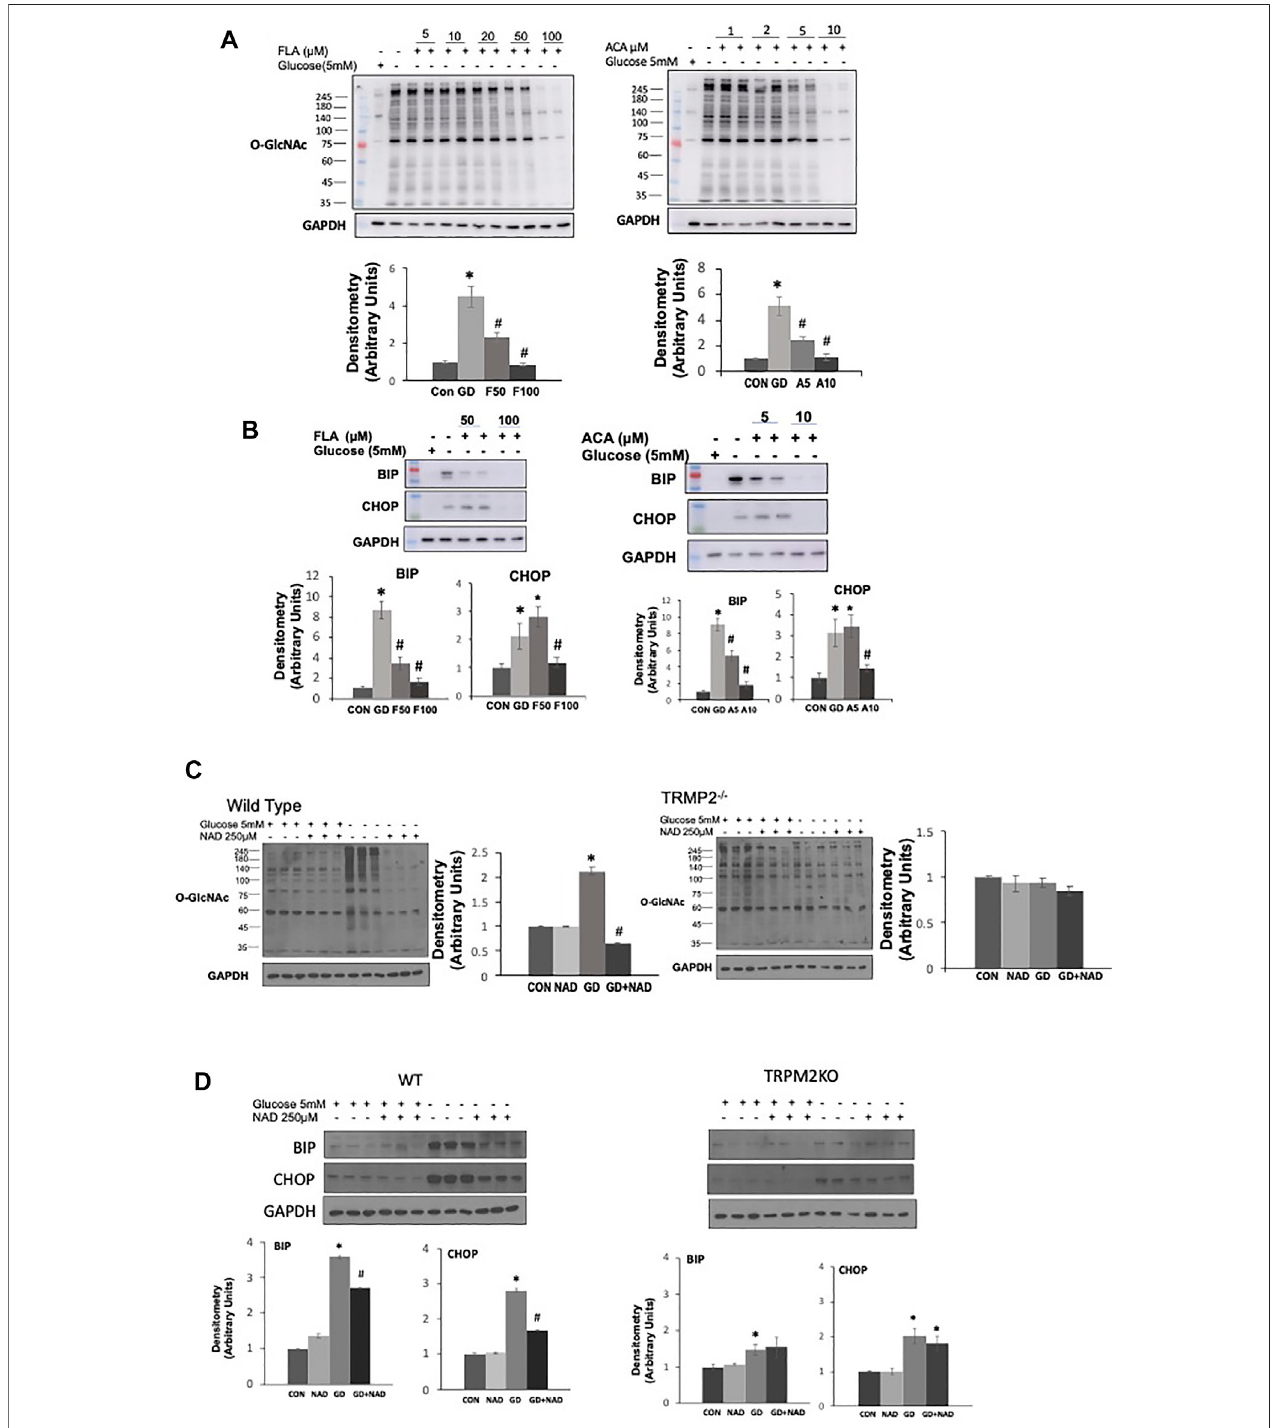
FIGURE4| TheeffectsofTRPM2inhibitioninAC16cells,orTRPM2deletioninMEFsontheglucosedeprivationinducedincreaseinO-GlcNAcandERStress: (A) Top Panels: O-GlcNAc immunoblots with and without glucose in the presence or absence of TRPM2 inhibitors FLA (5 – 100 µM) and ACA (1 – 10 µM); Bottom Panels: Quanti fi cation of immunoblots at 50 and 100 µM FLA and 5 and 10 µM ACA normalized to GAPDH. (B) Top Panels: BiP and CHOP immunoblots with and without glucose in the presence or absence of TRPM2 inhibitors FLA (50, 100 µM) and ACA (5, 10 µM); Bottom Panels: Quanti fi cation of immunoblots normalized to GAPDH. (C) LeftO-GlcNAcimmunoblotsfromwildtype(WT)andTRPM2 − / − cellswithandwithoutglucoseinthepresenceorabsenceofNAD + (250 µM);Quanti fi cation ofimmunoblotsforWTand TRMP2 − / − normalized toGAPDH. (D) Top Panels:ImmunoblotsforBiPandCHOPfrom wildtype (WT)and TRPM2 − / − cells withandwithout glucoseinthepresenceorabsenceofNAD + (250 µM);BottomPanels:Quanti fi cationofimmunoblotsforWTandTRPM2 − / − normalizedtoGAPDH.* p < 0.05vs.Control (Con) group; # p < 0.05 vs. glucose deprivation (GD) group. All data are expressed as mean ± S.E.M. of 3 – 6 independent experiments.